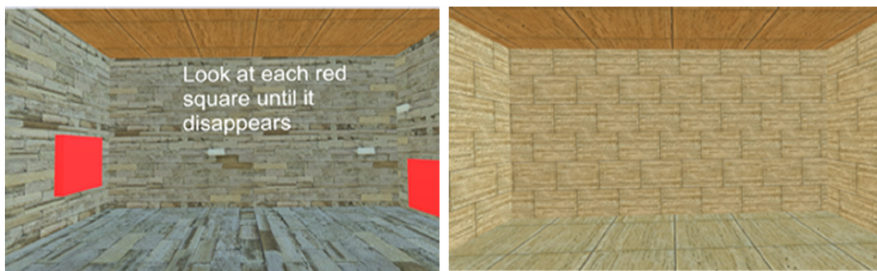
Figure 2. Virtual environments used in the study. Left: lobby environment, right: closed room environment.